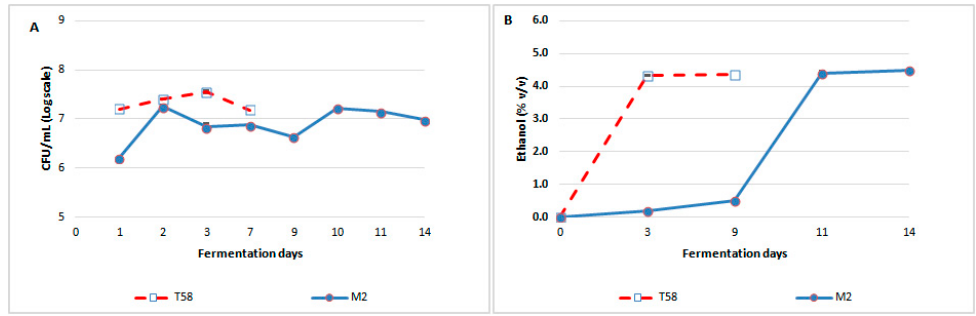
Figure 1. Worts fermented by H. uvarum L2 in subsequent fermentation with S. cerevisiae US-05 (M2) and S. cerevisiae T-58 (T58): ( A ) Yeast concentration during alcoholic fermentation; ( B ) kinetic of the ethanol (% v / v ) production. Data are reported as means of two measurements (error bars related to SD lie below the symbols).